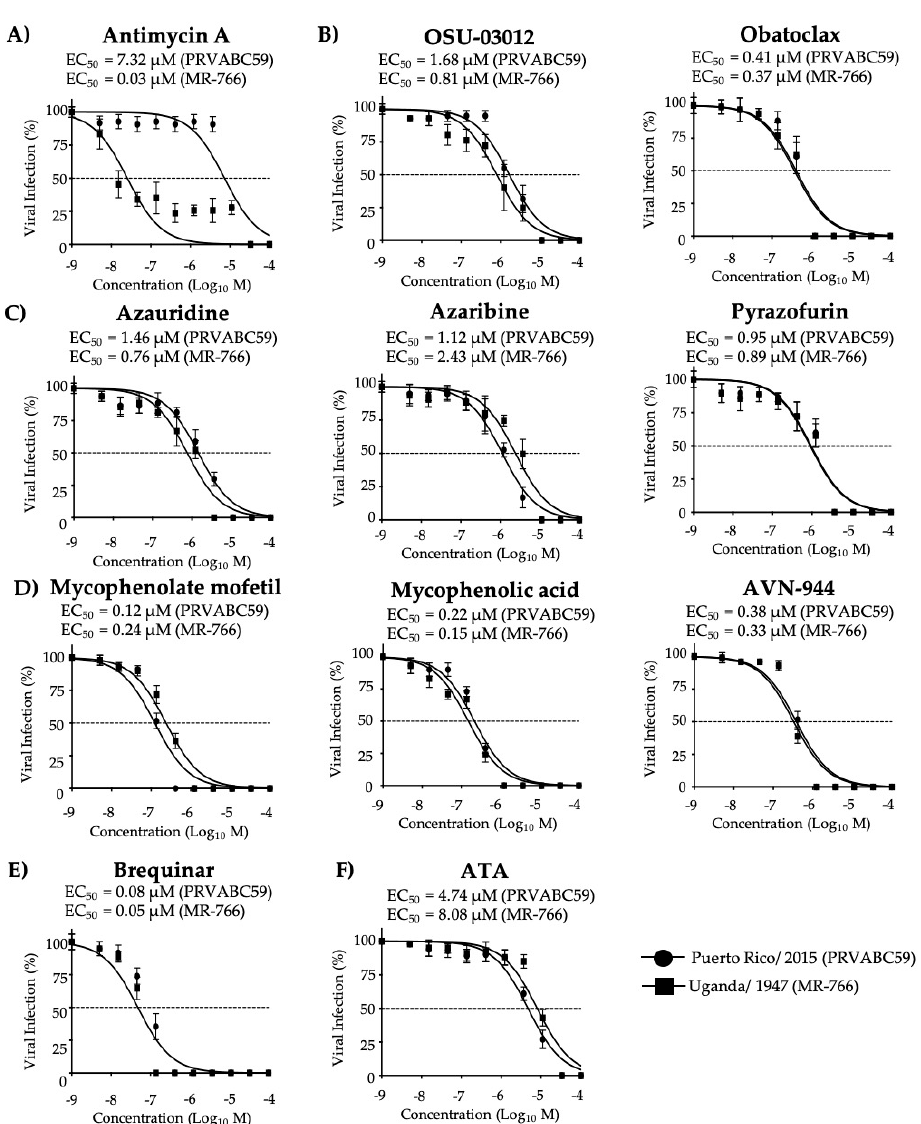
Figure 8. Inhibition of African (MR-766) and Asian / American (PRVABC59) prototype ZIKV strains: Vero cells (96-well plates, 5 × 10 4 cells / well, quadruplicates) were infected with 25 PFU of MR-766, and 50 PFU of PRVABC59 ZIKV strains. After 2 h viral absorption, the indicated concentrations of compounds (3-folds dilutions, starting concentration 100 µ M) ( A ) Antimycin A, ( B ) OSU-03012 and Obatoclax, ( C ) Azaribine, Azauridine, and Pyrazofurin, ( D ) Mycophenolate mofetil, Mycophenolic acid, and AVN-944, ( E ) Brequinar, and ( F ) Aurintricarboxylic acid (ATA) were added to post-infection media. Infected cells were fixed for virus titration by immunostaining assay at 36 h (MR-766) or 48 h (PRVABC59) post-treatment. Dotted line indicates 50% inhibition. Data were expressed as mean and SD from three independent experiments conducted in quadruplicates.